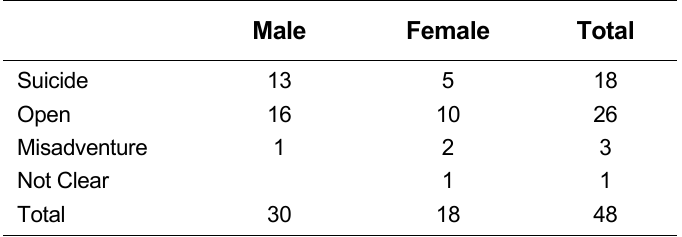
Identified Self-Harm Fatality while Under Psychiatric Care